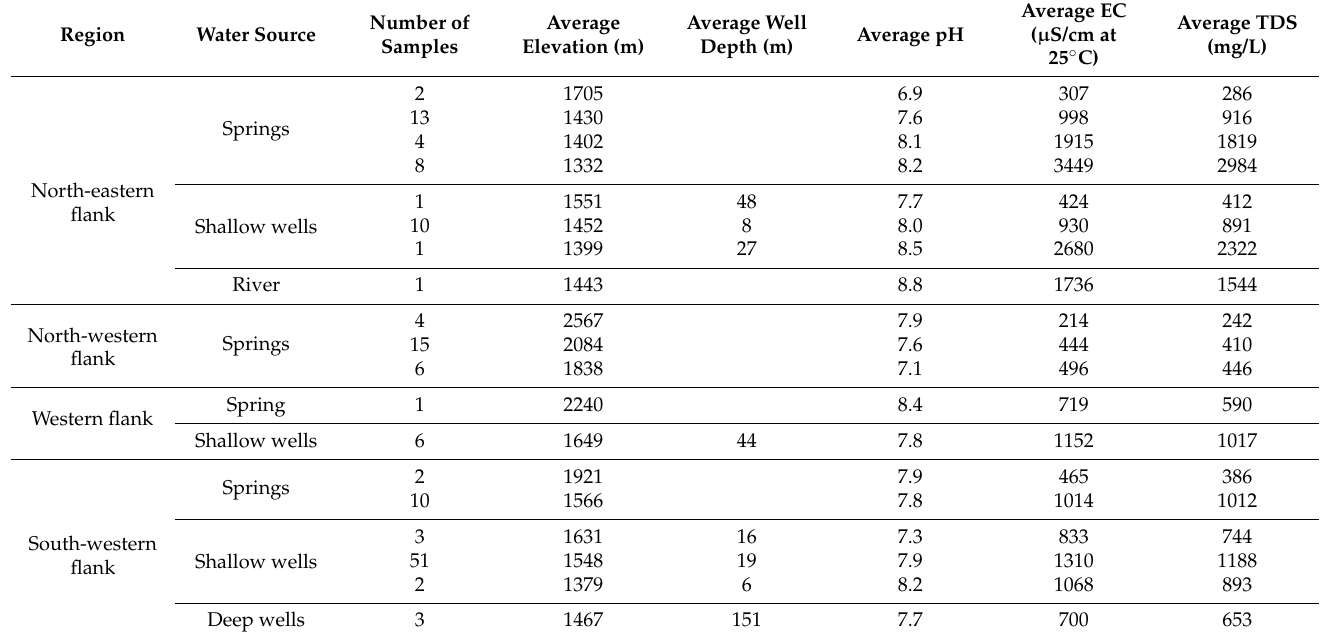
Table 3. Average values of pH, EC, and TDS in the water samples from different elevations and different well depths on the northeastern, northwestern, western, and southwestern flank of Mount